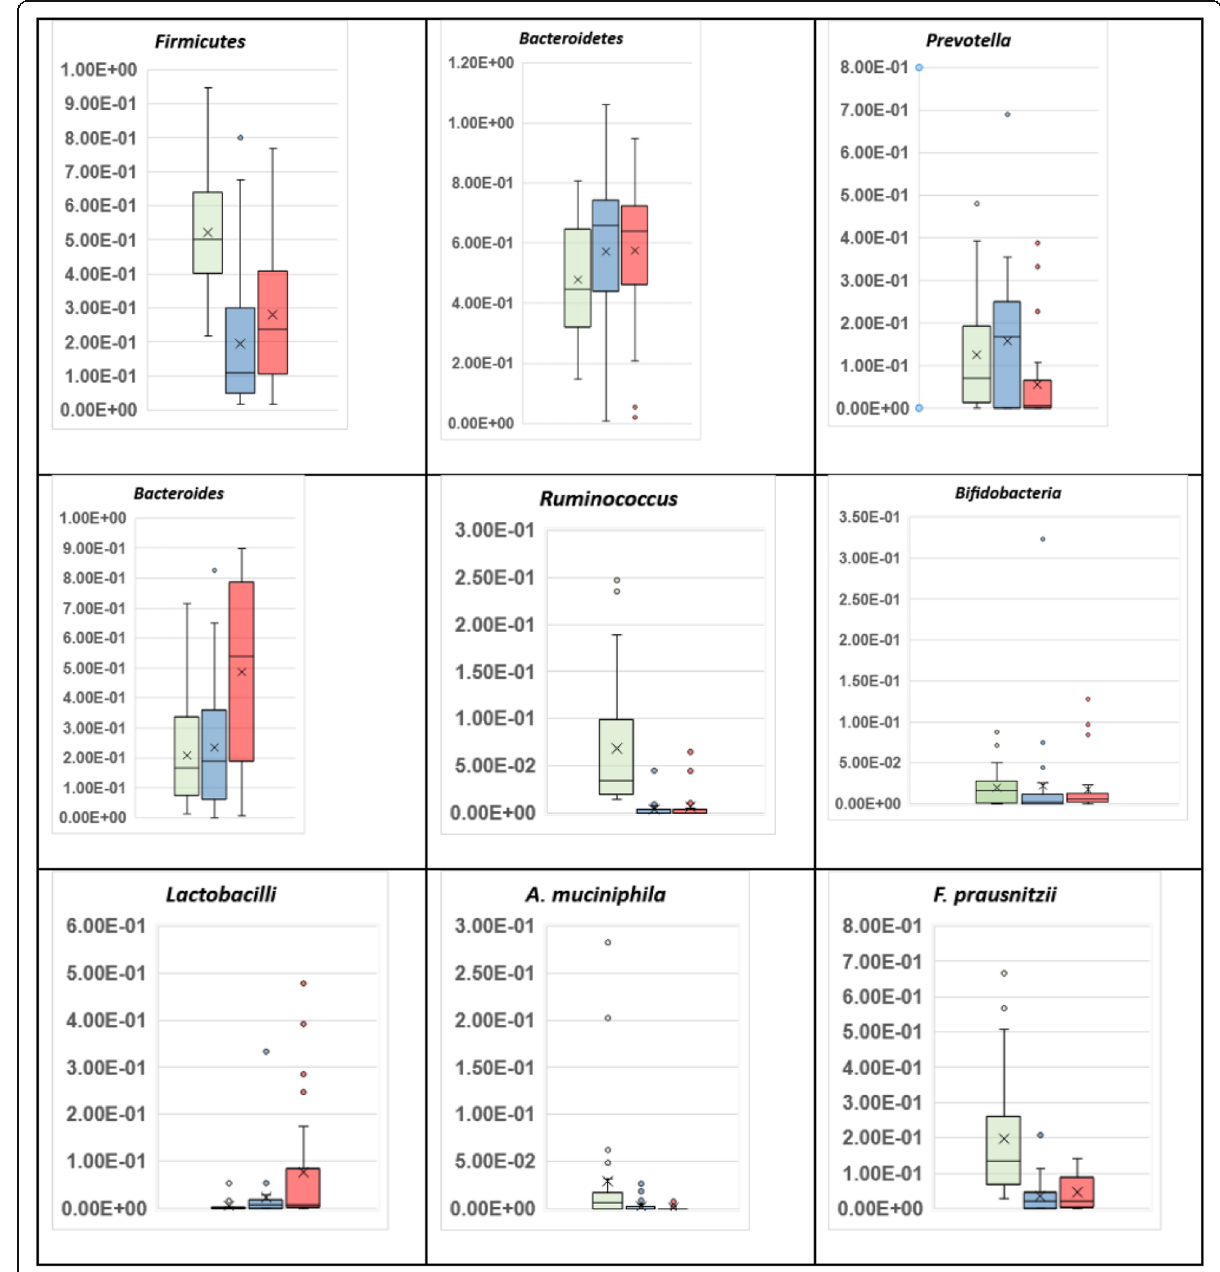
Fig. 1 Box and whisker graph of gut microbiome in the studied groups. The thick line in the middle of the box represents the median, the box represents the inter-quartile range (from 25th to 75th percentiles) and the whiskers represent the minimum and maximum.